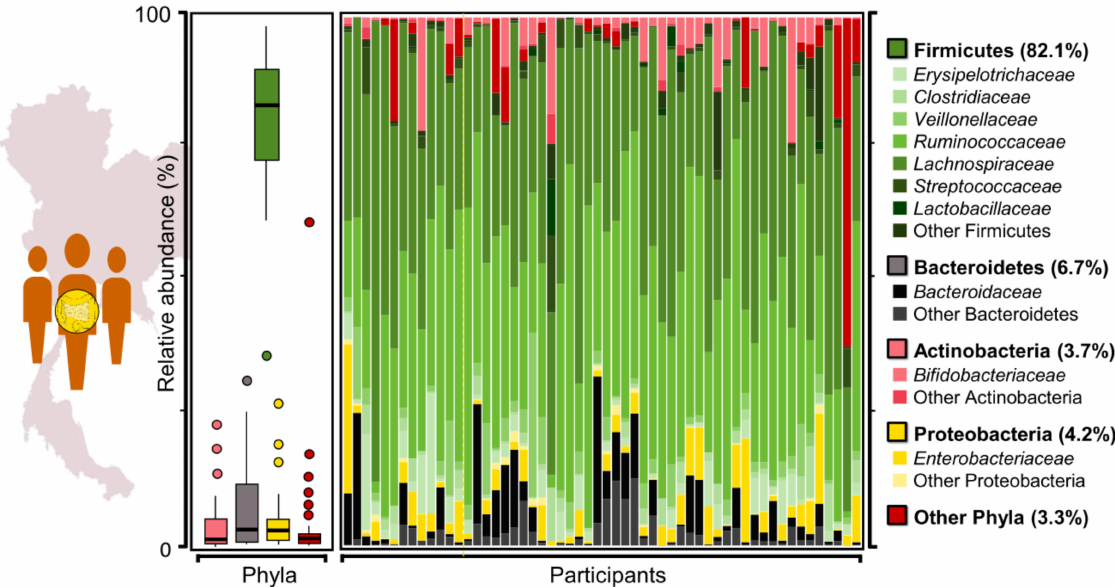
Figure 1. The taxonomic profiles of gut microbiome from Thai adults using 16S rRNA gene sequencing